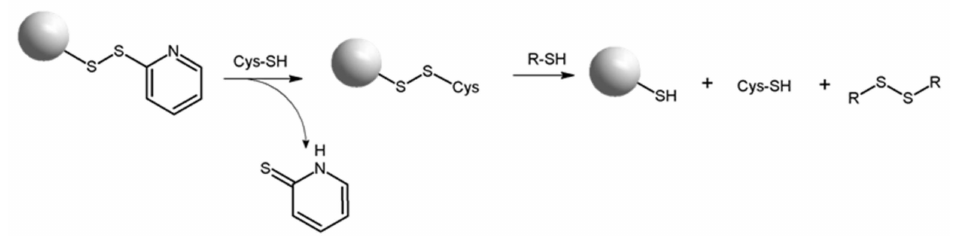
Figure 1. Schematic presentation of cysteine-containing peptide enrichment by Thiopropyl Sepharose 6B. R-SH represents a low molecular weight thiol, such as